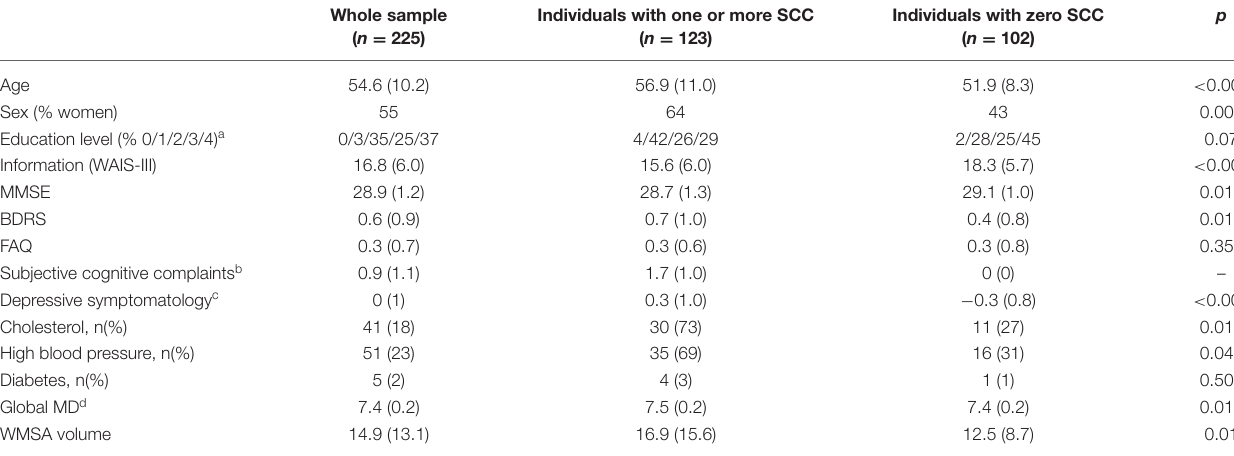
TABLE 1 | Demographic and clinical